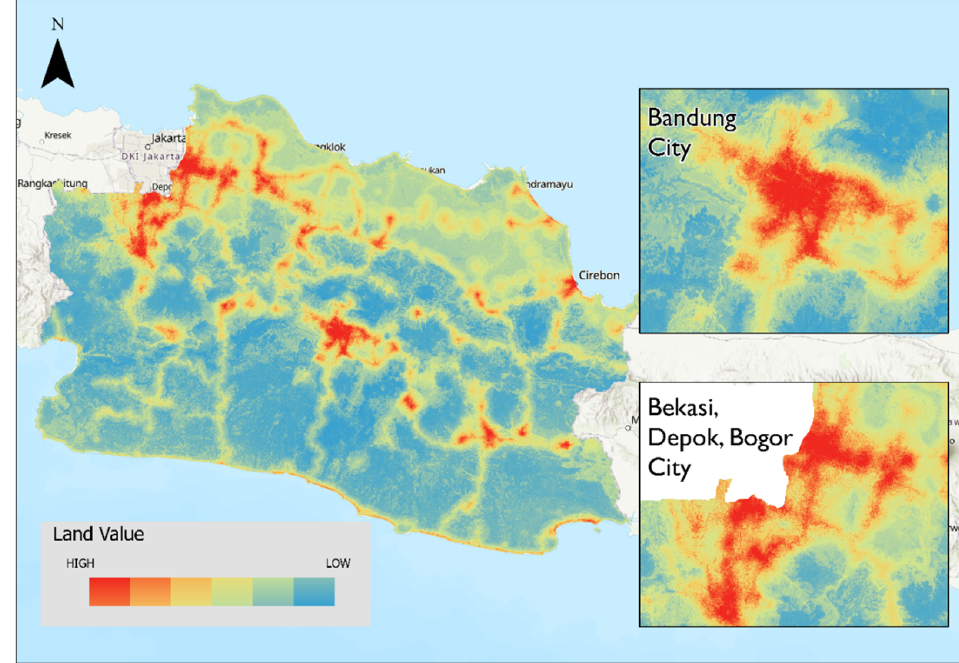
Figure 13. Relative land value in the West Java Province area.